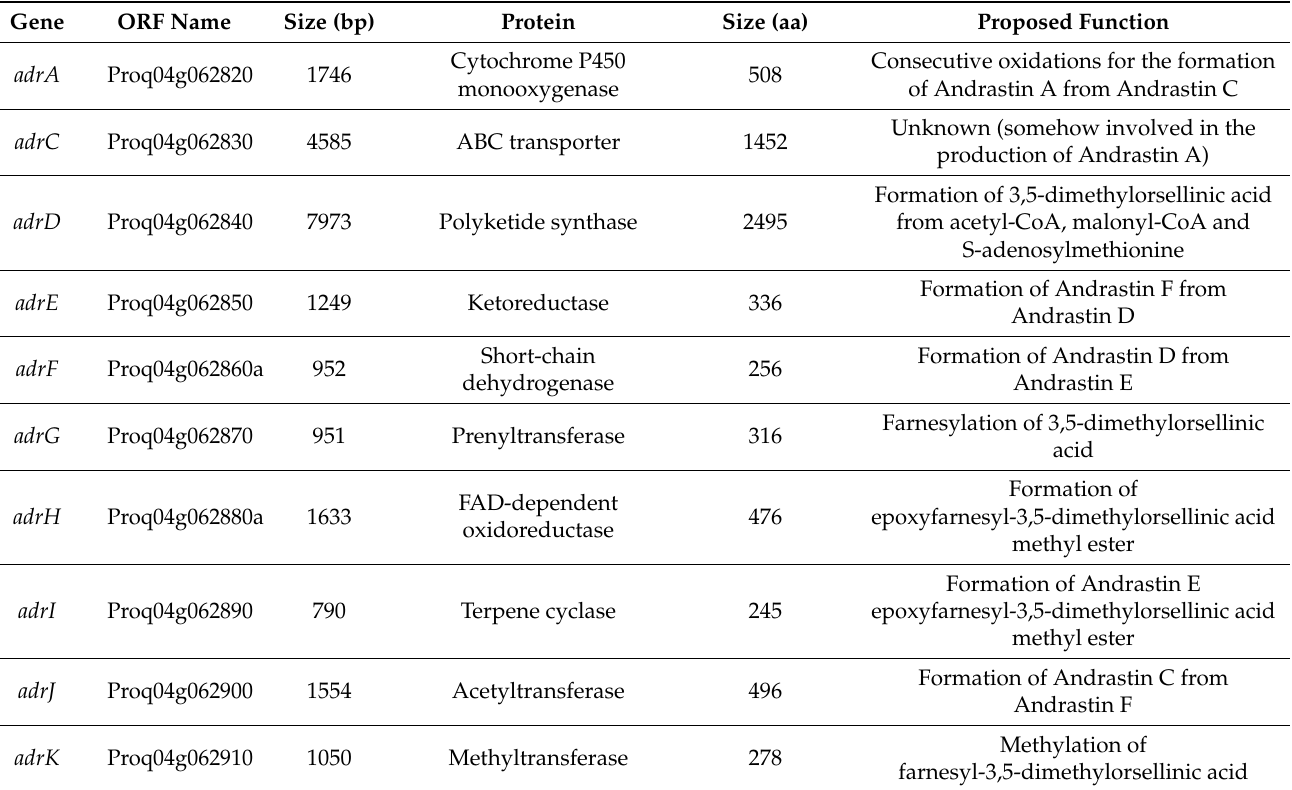
Table 5. Andrastin A biosynthetic gene cluster in P. roqueforti